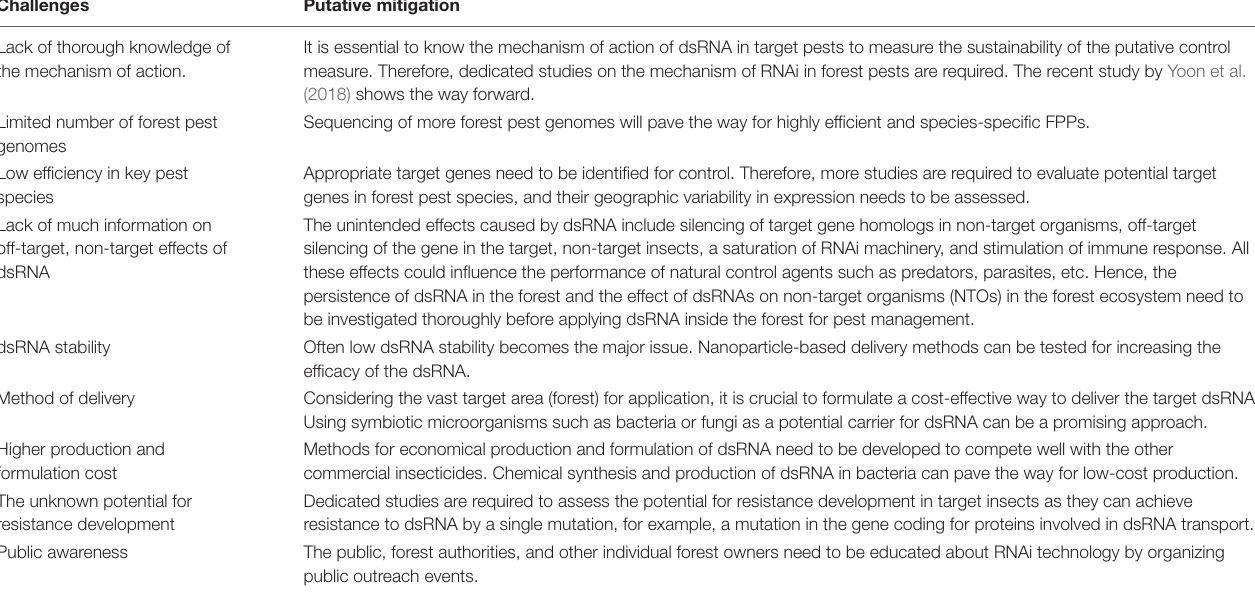
TABLE 2 | Challenges and putative mitigation strategies for the deployment of dsRNA-based forest protection products (FPPs). Challenges Putative mitigation Lack of thorough knowledge of the mechanism of